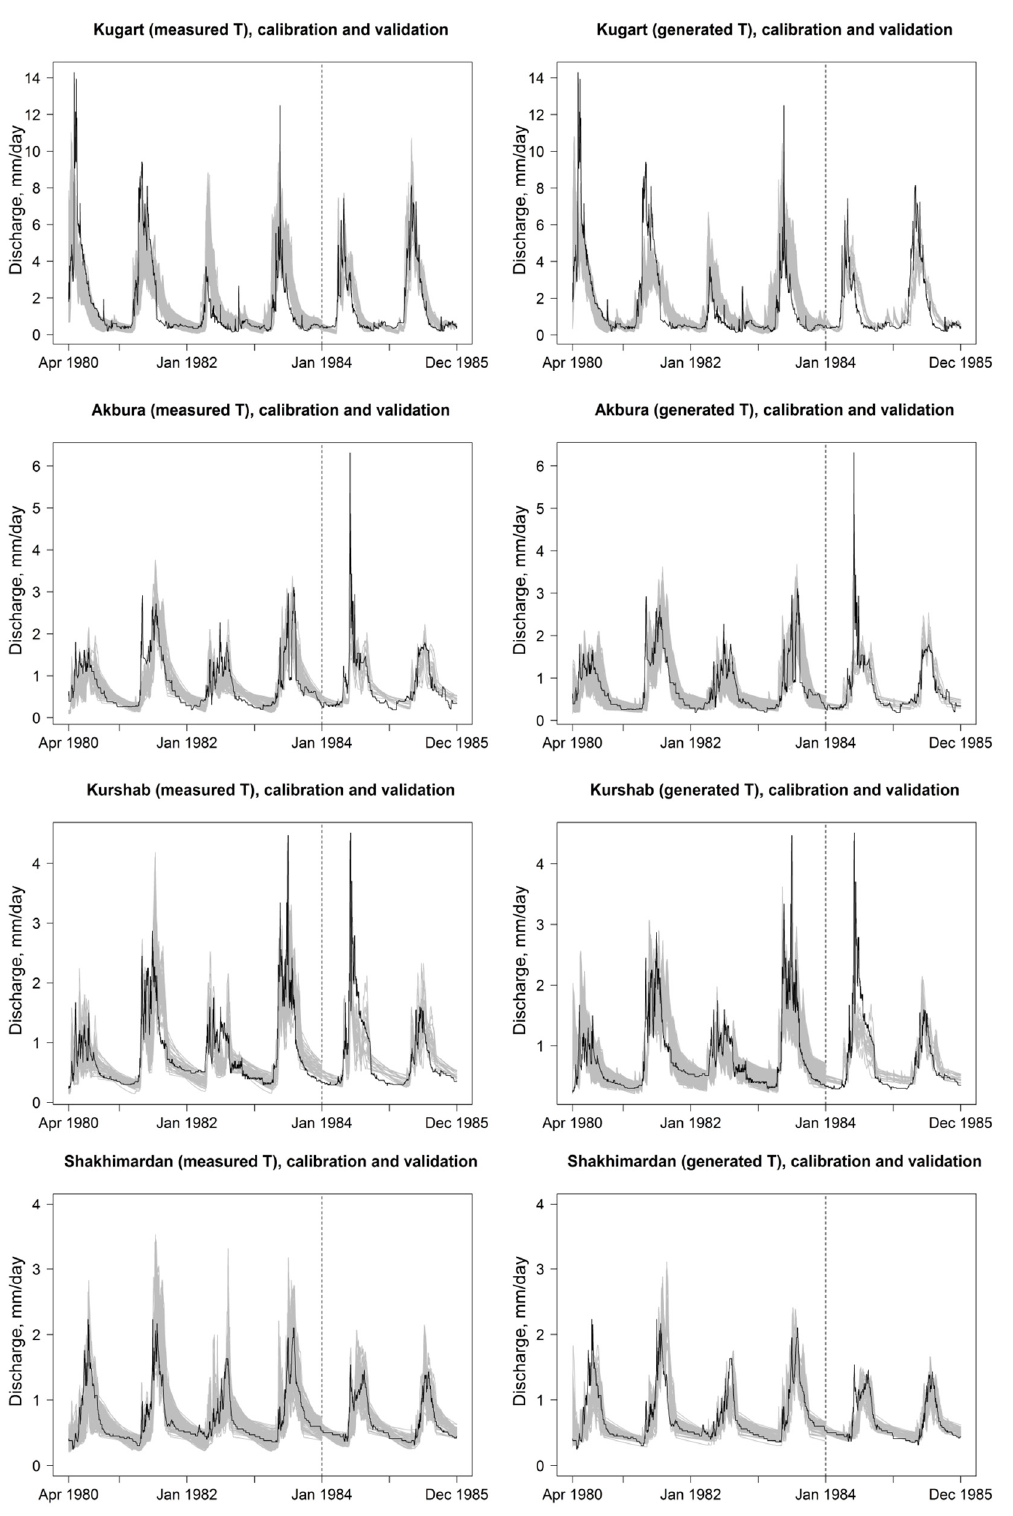
Figure 8. Observed (black line) and simulated (grey lines) discharge series for calibration and validation periods (separated by vertical dashed line) using allocated measured ( left ) and generated ( right ) temperature and precipitation data for the studied